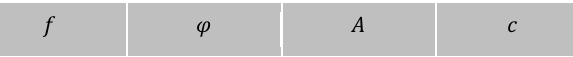
Figure 2. The unknowns for a sinusoidal fitting adjustment